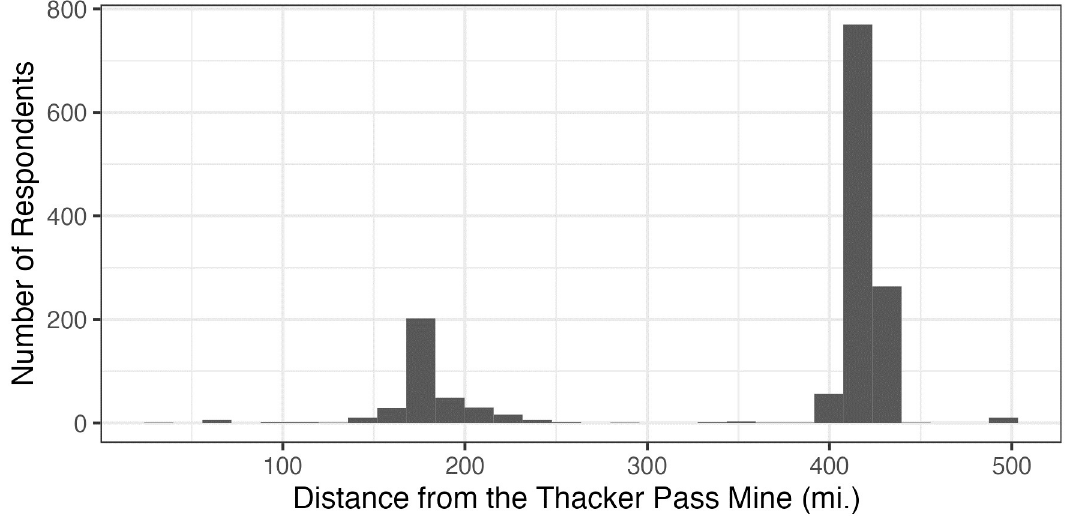
Fig 2. Geographical distribution of respondents in relation to the Thacker Pass lithium